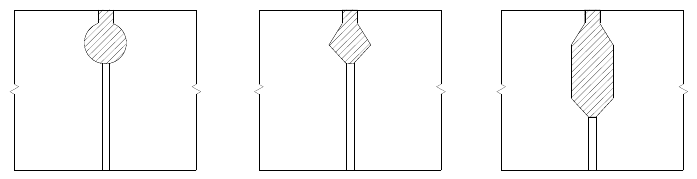
Figure 3. Common hinge joint form of the hollow plate beam.